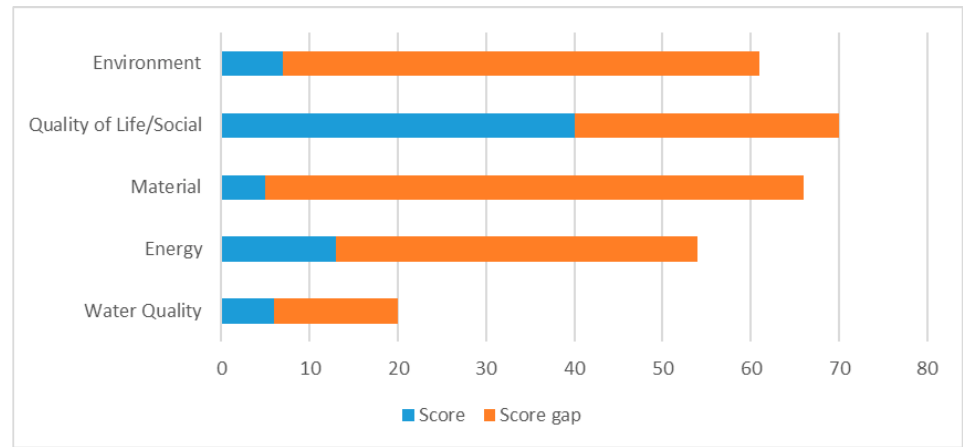
Figure 6. Points achieved in relation to applicable points across each category of the triple bottom line used in this research for the GreenLITES rating system for Project 1.